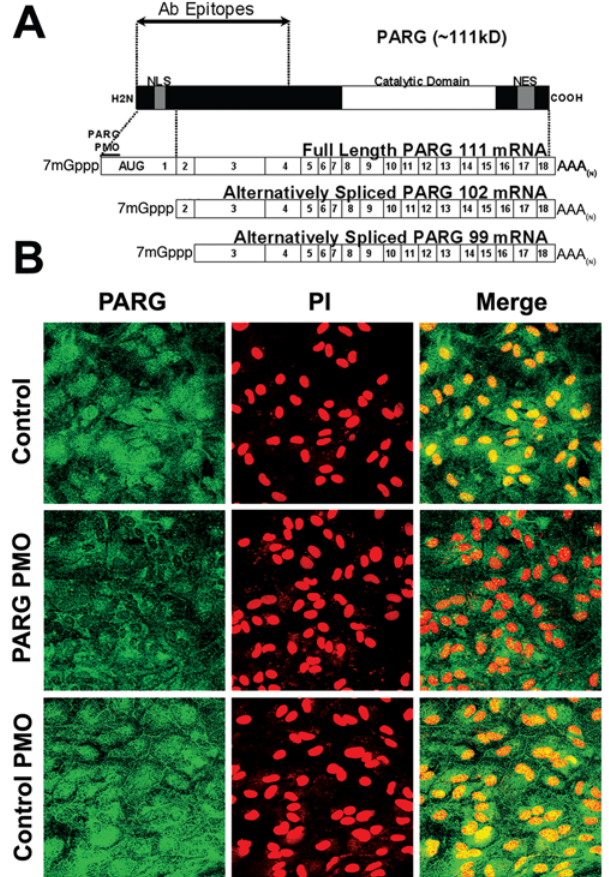
Figure 1. Nuclear PARG protein expression is reduced by the PARG antisense PMO targeted to exon 1. ( A ) The full-length 111 kD protein contains a nuclear localization sequence (NLS) in exon 1 and a nuclear export sequence (NES) near the carboxy terminus. The anti-PARG antibody targets the peptide fragment indicated [27]. The PARG antisense PMO was directed to the extreme 5 9 end of exon 1 of the full-length PARG mRNA. ( B ) Astrocytes are immunostained for PARG (green), and nuclei are counterstained with propidium iodide (red). Merged images demonstrate a reduction in PARG expression, mainly in the nuclei, after PARG PMO treatment, as compared to both the no PMO (Control) condition and the inverted sequence PMO (Control PMO) condition. Scale bar=20 m m. Images are representative of 6 indepen- dent experiments with similar results.